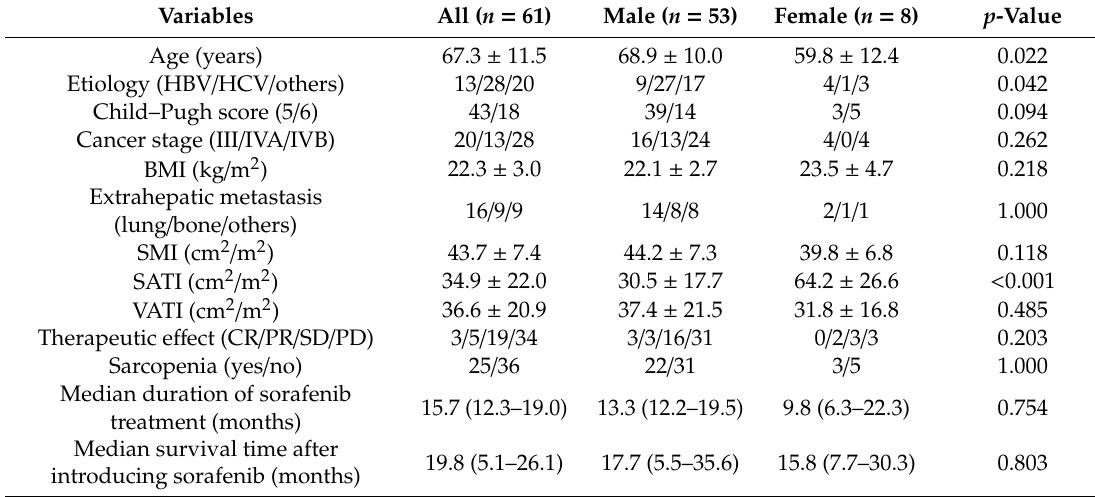
Table 1. Baseline demographic and clinical characteristics of the enrolled patients just before the introduction of sorafenib.